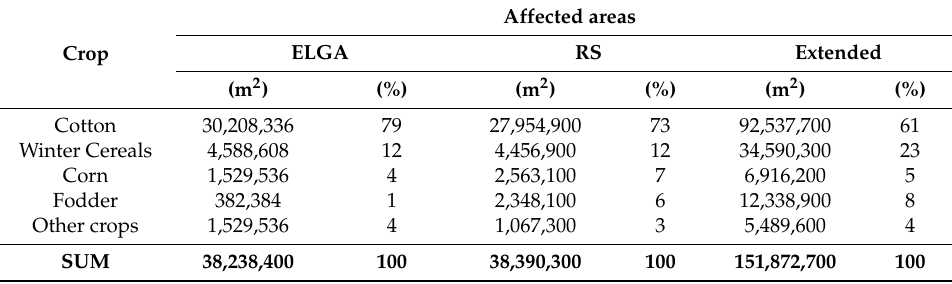
Table 4. Affected areas statistics according to the Greek Agricultural Insurance Organization (ELGA) compensations, to the flooded areas limited to the flooded polygons delimited by RS, and to the flooded area extended outside the boundaries of the delimited polygons